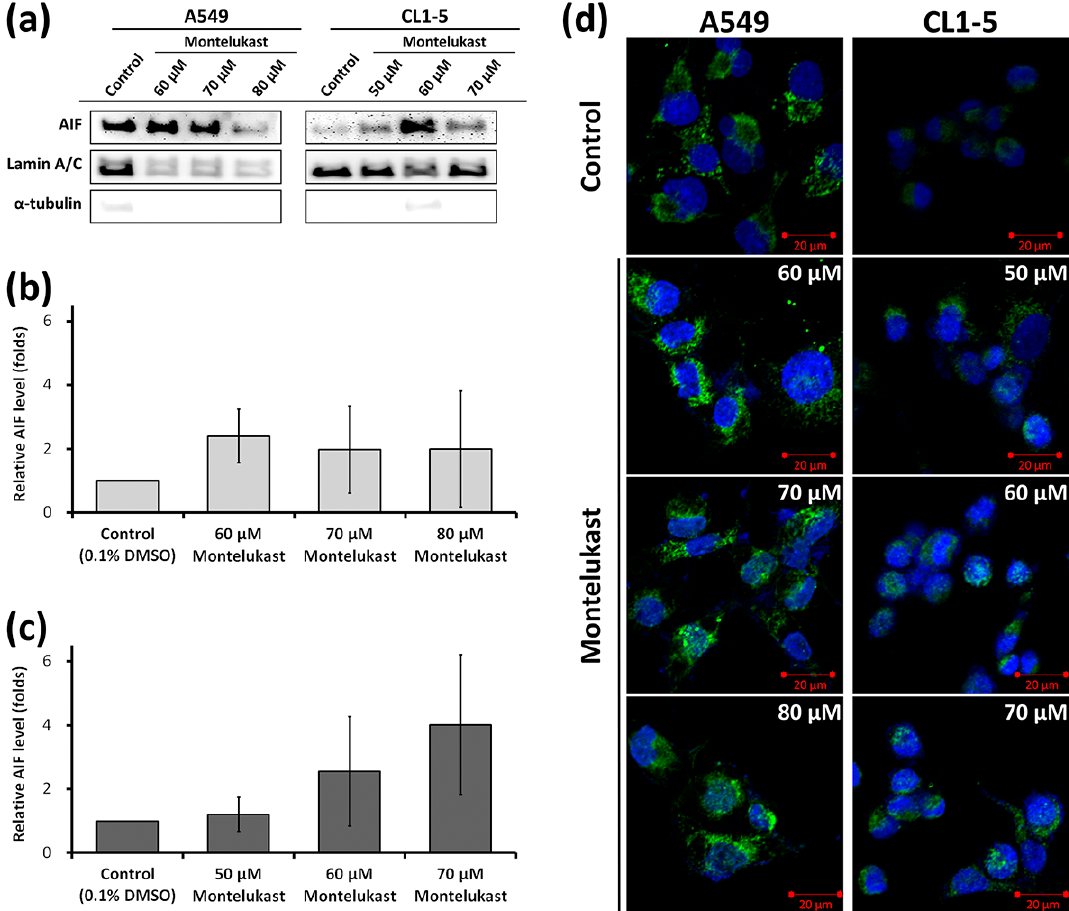
Figure 4 . Montelukast-induced nuclear translocation of apoptosis-inducing factor (AIF) in lung cancer cells. ( a – c ) The cells (A549 and CL1-5) were treated with 0.1% dimethyl sulfoxide (DMSO) (control) or montelukast for 24 h. The levels of AIF in the nuclei were assessed with immunoblot assay. The results shown are representative photographs ( a ) of multiple experiments, along with the means ± SD of the relative levels to the lamin A/C levels and to the control groups ( b , A549; c , CL1-5); ( d ) The cells (A549 and CL1-5) were treated with 0.1% DMSO (control) or various concentrations of montelukast for 24 h. The nuclear translocation of AIF was demonstrated with immunofluorescence staining and laser scanning confocal microscopy. Blue, DAPI-labeled nuclei; green, AIF.